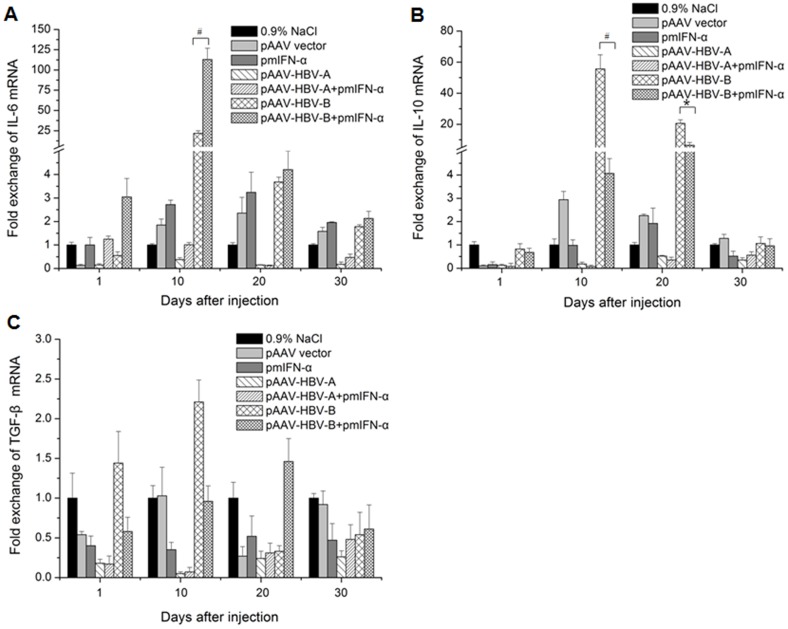
Expression levels of IL-6, IL-10 and TGF-β in the mouse liver after HI.Mice received HI with 10 µg of HBV clones or pmIFN-α alone or combination of HBV clones and pmIFN-α. The mice injected with 0.9% NaCl or pAAV vector, were used as control. Total RNA was extracted form liver tissue of the mice at the indicated time points after HI and the levels of IL-6 (A), IL-10 (B) and TGF-β (C) mRNA were determined by quantitative real-time RT PCR. The β-actin mRNAs were quantified for normalization. Each sample was run in duplicate and at least three mouse liver specimens per group were analyzed (n≥3). Differences between the groups were analyzed by using the t test: * means p<0.05 and # means p<0.01.